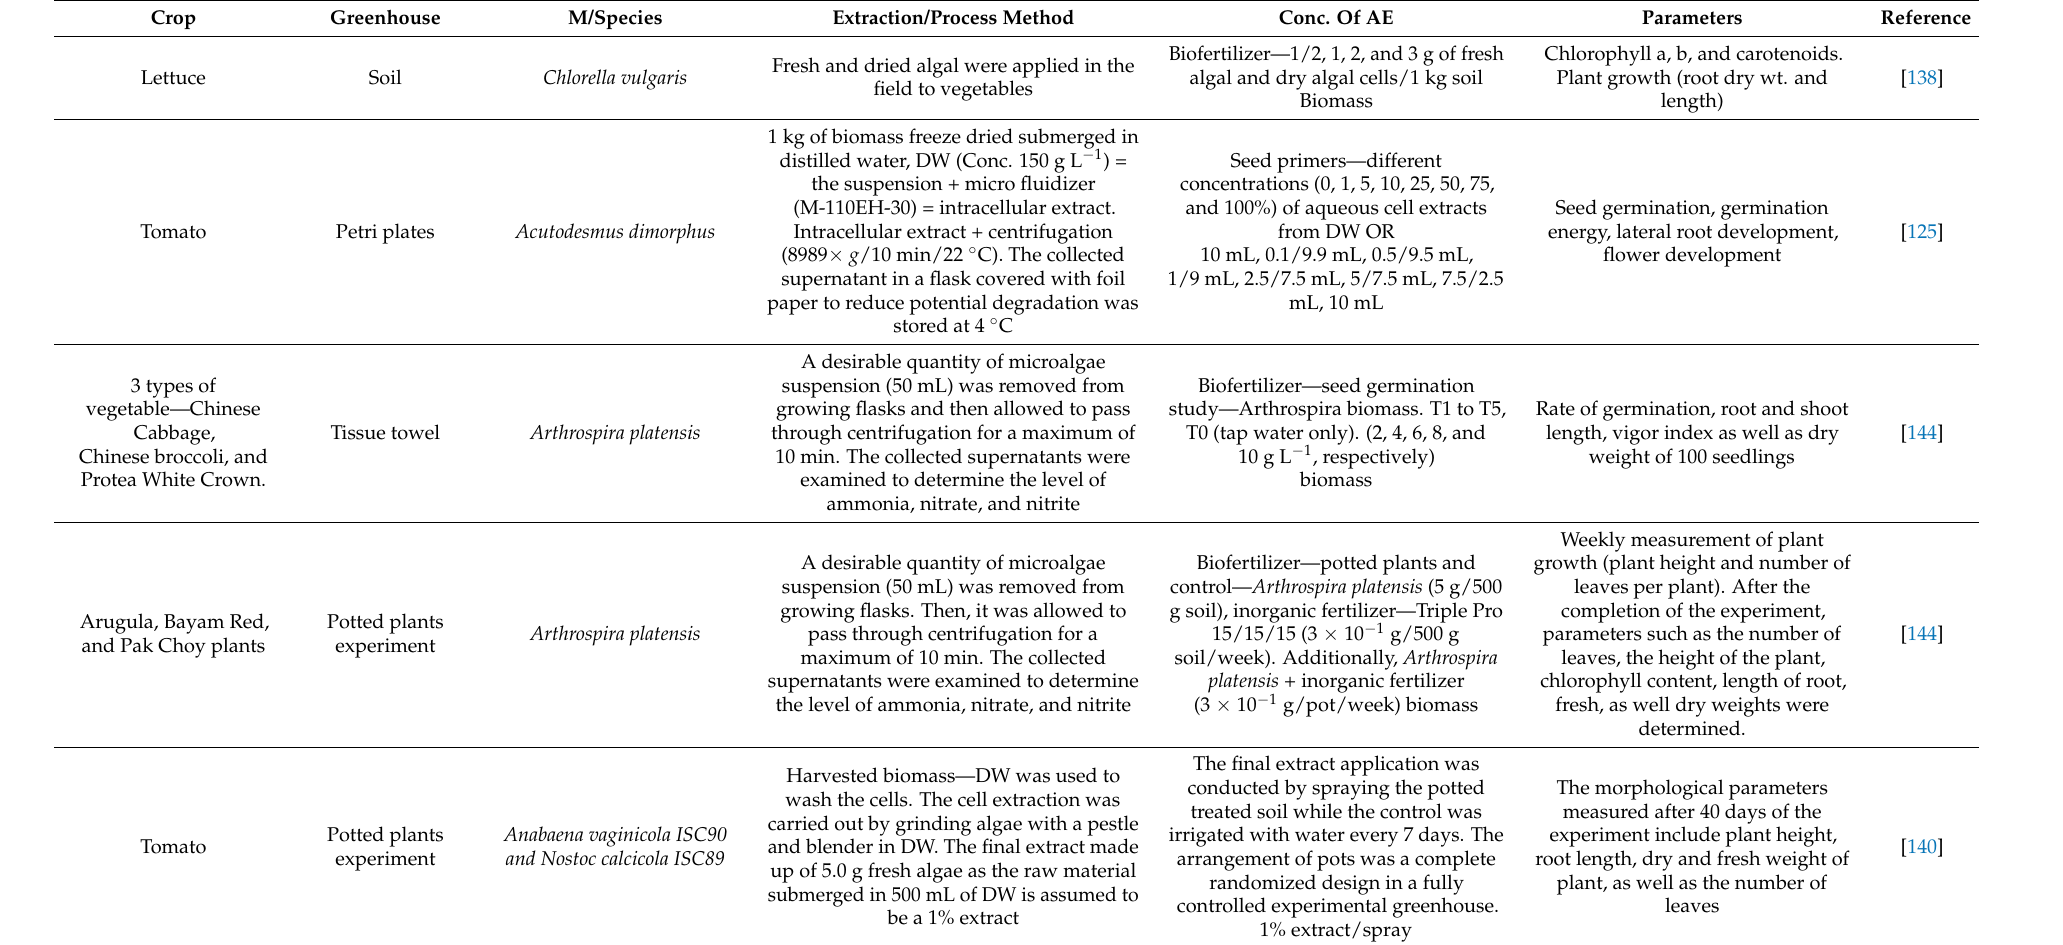
Table 6. The morphological and molecular responses resulting from the application of microalgae in high-value products and whole biomass from various microalgae species.